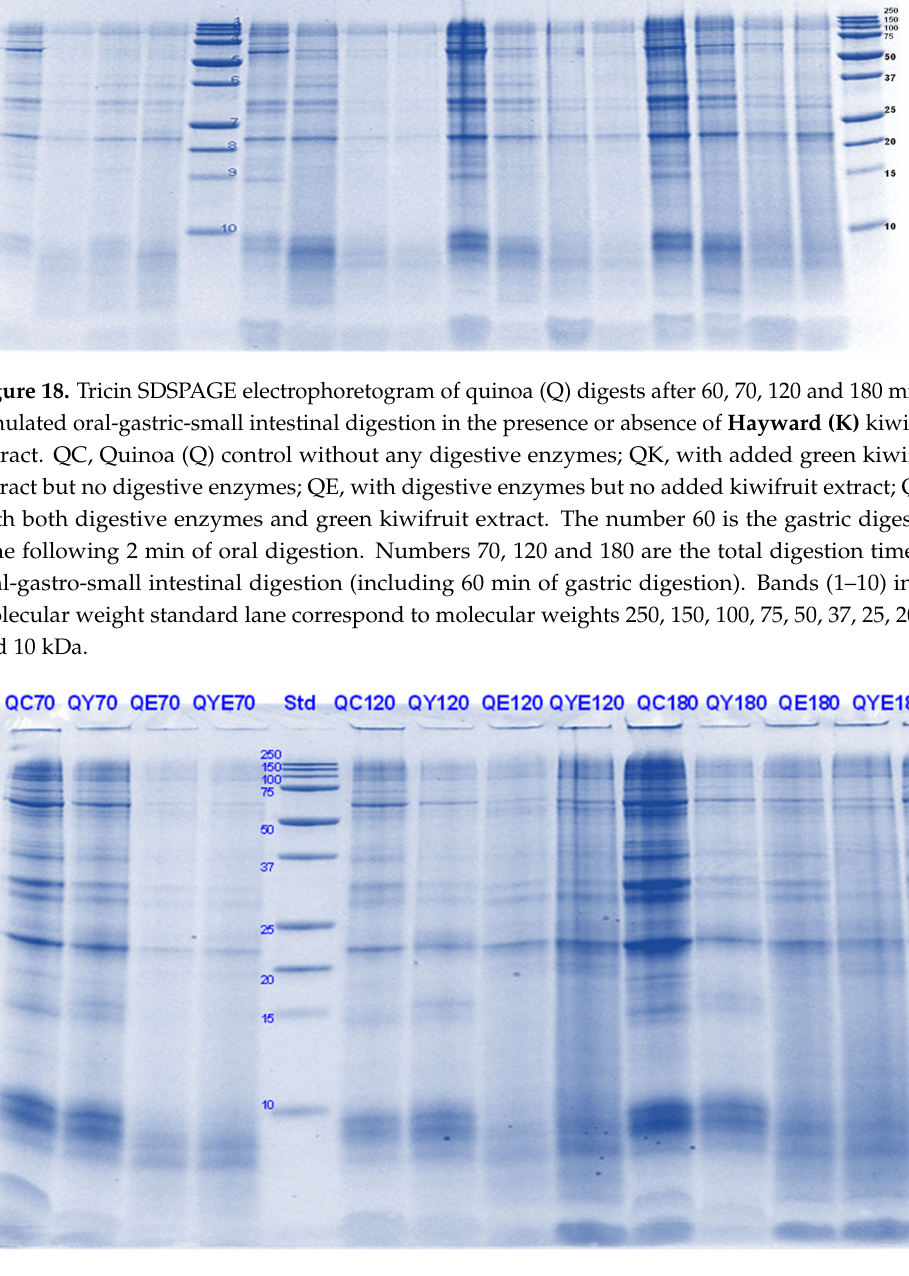
Figure 19. Tricine-SDS-PAGE electrophoretogram of quinoa (Q) digests after 70, 120 and 180 min of simulated oral-gastric-small intestinal digestion in the presence or absence of SunGold (Y) kiwifruit extract. QC, Quinoa (Q) control without any digestive enzymes; QY, with added gold kiwifruit extract but no digestive enzymes; QE, with digestive enzymes but no added kiwifruit extract; QKY, with both digestive enzymes and gold kiwifruit extract. Numbers 70, 120 and 180 are the total digestion times in oral-gastro-small intestinal digestion (including 60 min of gastric digestion). Bands (top to bottom) in the molecular weight standard lane (Std) correspond to molecular weights 250, 150, 100, 75, 50, 37, 25, 20, 15 and 10